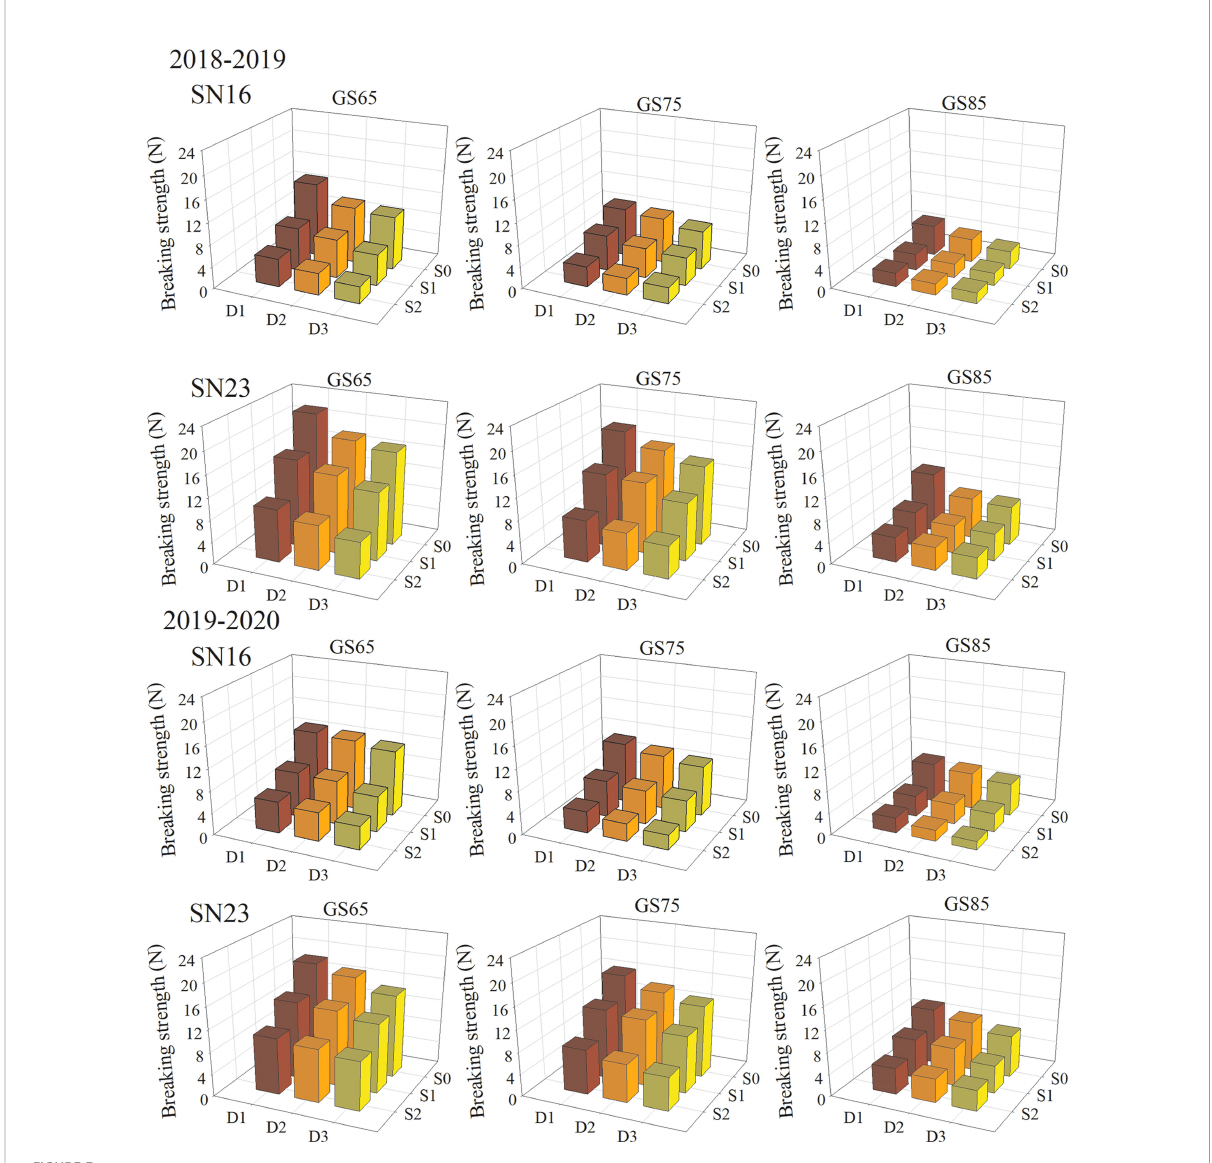
FIGURE 3 Effects of shading on breaking strength in different winter wheat populations at anthesis